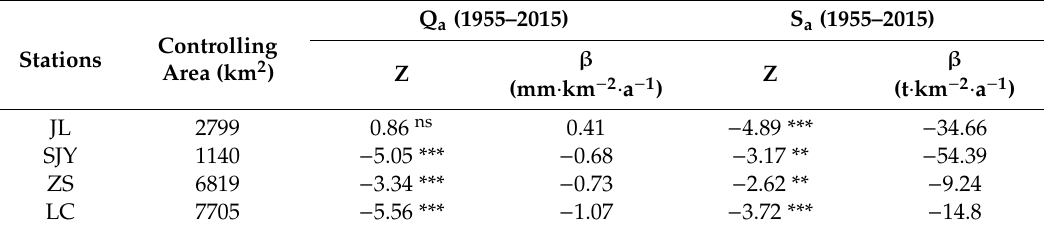
Table 2. Q a and S a trends revealed by the Mann–Kendall tests.